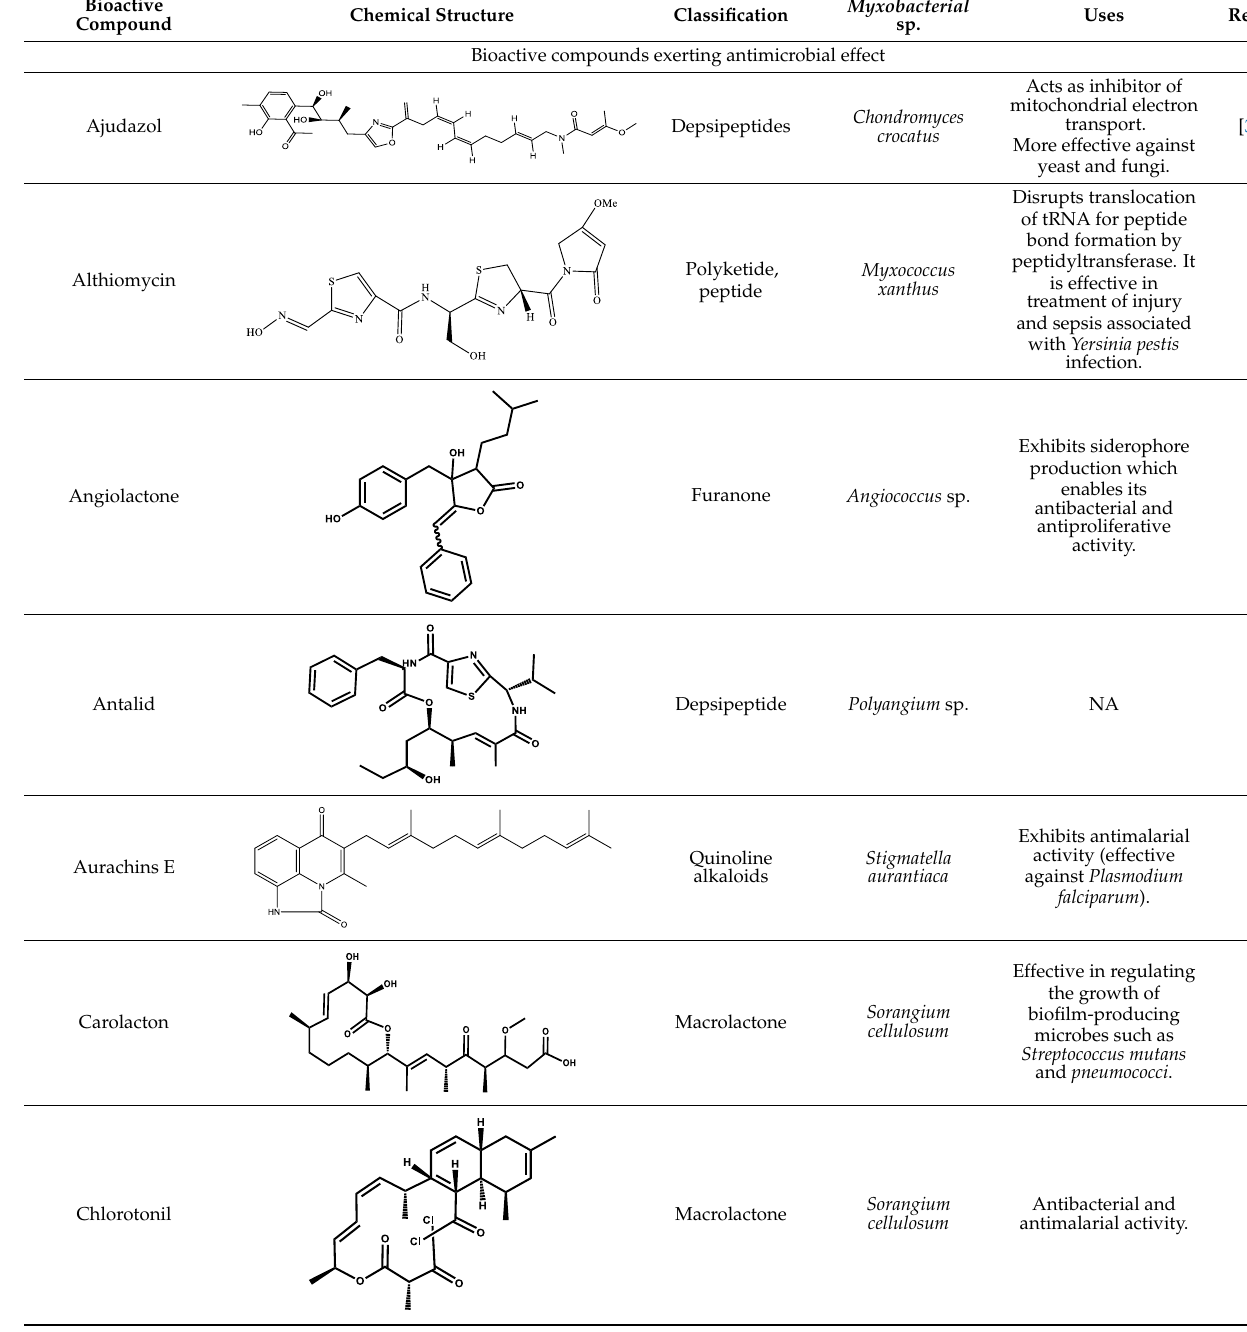
Table 1. Categorization of Myxobacterial- derived secondary metabolites based on their function.